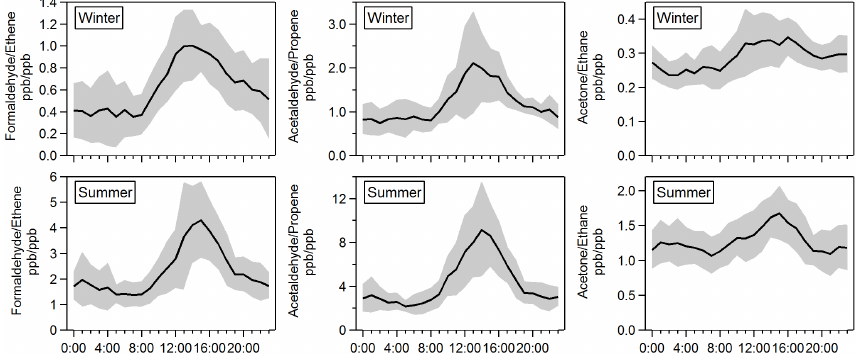
Fig. 1. Diurnal variations of measured ratios of formaldehyde/ethene, acetaldehyde/propene, and acetone/ethane at the PKU site during winter and summer. Black lines represent the average values and grey shaded areas indicate standard